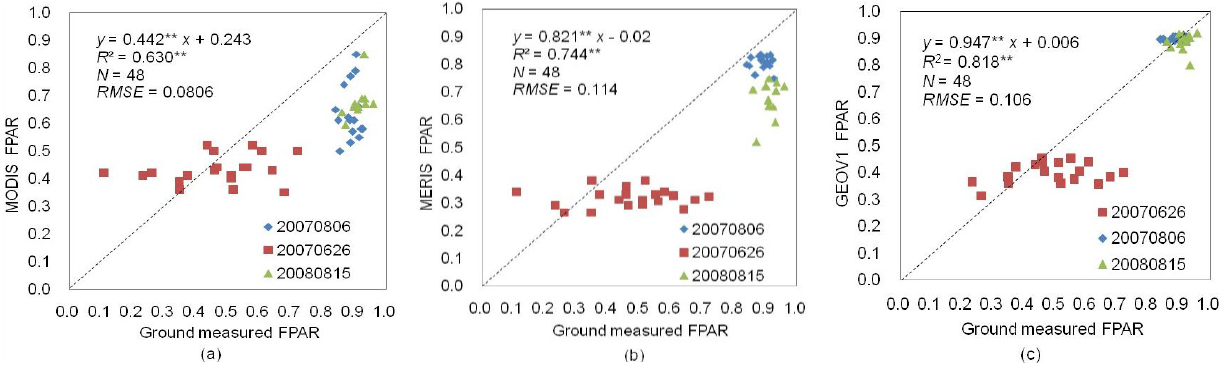
Figure 2. Validation of maize FPAR products based on ground measured ( a ) MODIS FPAR; ( b ) MERIS FPAR; ( c ) GEOV1